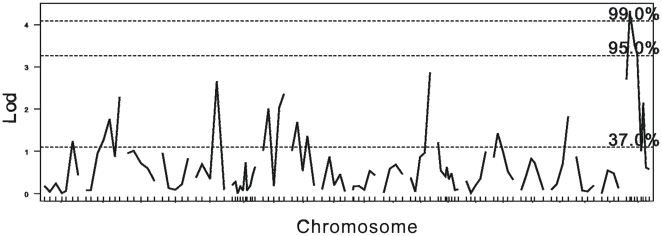
Linkage data for age at VO in the mixture F2 population.The horizontal axes indicate chromosomal locations and marker order between markers. LOD scores of 2.00, 3.26, 3.95 are established as the cut-offs for statistical significance (p<0.63, p<0.05 and p<0.01 respectively).